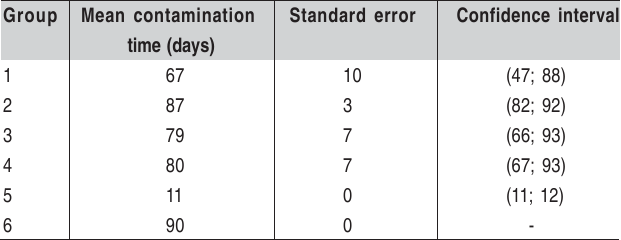
Table 1 - Contamination time of each group.